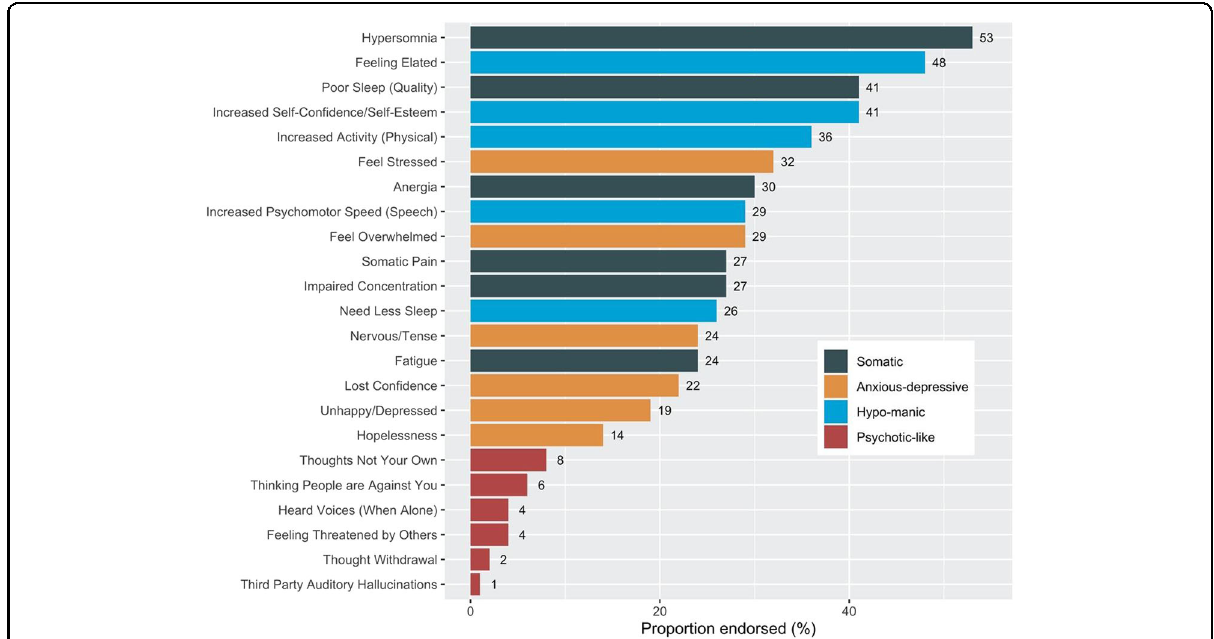
Fig. 1 Prevalence of self-rated somatic, anxious-depressive, hypomanic, and psychotic-like symptoms in a community-based cohort of young adults. Percentages are reported to the nearest whole